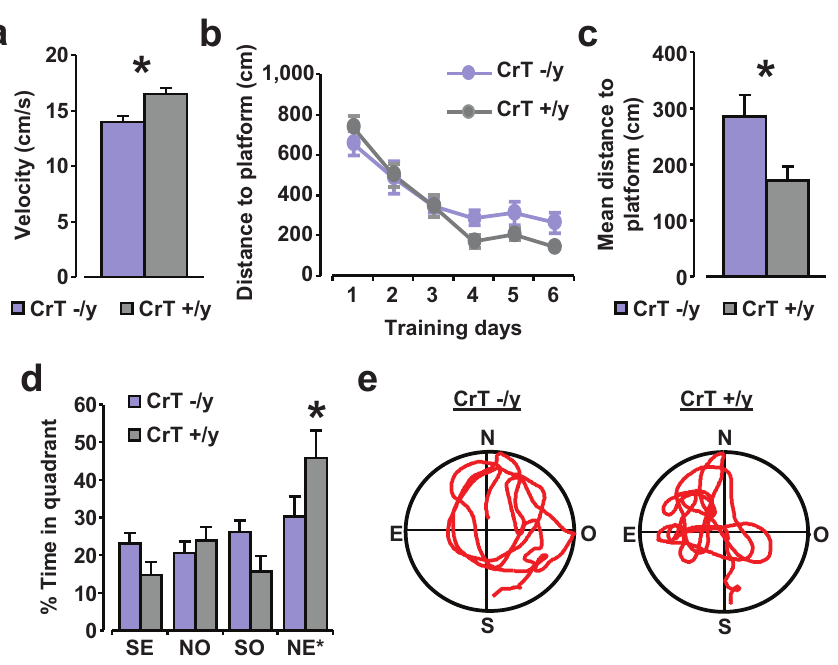
Figure 6. CrT deletion impairs spatial learning and memory in mutant mice. ( a ) Mean swimming speed measured all along the training phase for CrT –/y and CrT +/y animals: mutant mice (14.00 ± 0.53 cm/s) resulted to be slower swimmers with respect to control littermates (16.44 ± 0.60 cm/s; t test, p < 0.05). ( b , c ) Learning curves for CrT –/y (n = 9; blue) and CrT +/y mice (n = 5; grey) during the training phase. The histogram shows the mean swimming path covered to locate the submerged platform on the last three day of training for the two groups. A t-test analysis showed a statistical difference between CrT –/y (285.24 ± 37.53 cm) and CrT +/y animals (171.58 ± 23.80 cm; p < 0.05). ( d ) Probe trial. A Two-Way RM ANOVA followed by Holm-Sidak multiple comparison revealed that while CrT +/y spent significantly more time in the NE quadrant than in the other ones, CrT –/y did not show any preference for the target quadrant. In addition, the percentage of time spent in the target quadrant was shorter in CrT –/y mice (30.31 ± 5.33%) than in the other group (45.73 ± 7.35%). ( e ) Representative examples of swimming path during the probe session for a CrT –/y (left) and a CrT +/y mouse (right). *, statistical significance. Error bars, s.e.m.